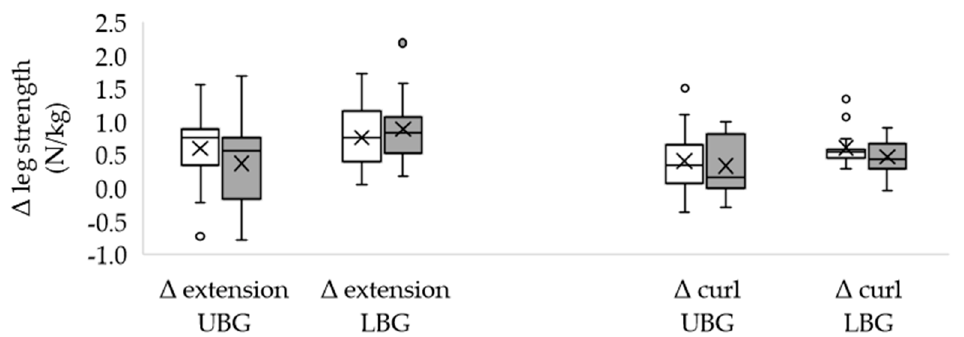
Figure 4. Differences between the final and the initial body weight adjusted maximum leg strength